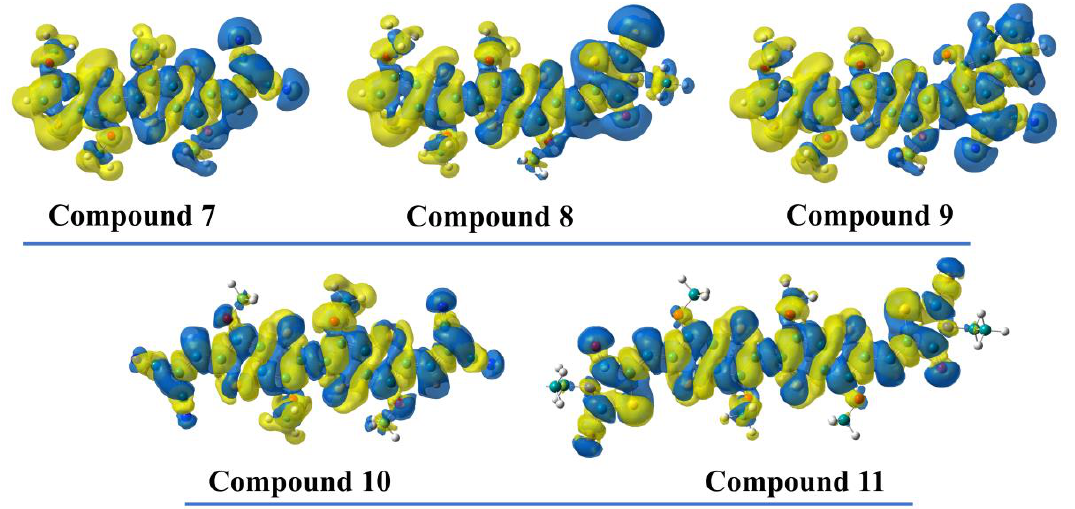
Figure 6. Electron difference density plots between first excited state and ground state for com- pounds 7 – 11 . Density depletion is depicted in yellow and density accumulation is plotted in blue (isosurface value = 0.0001).